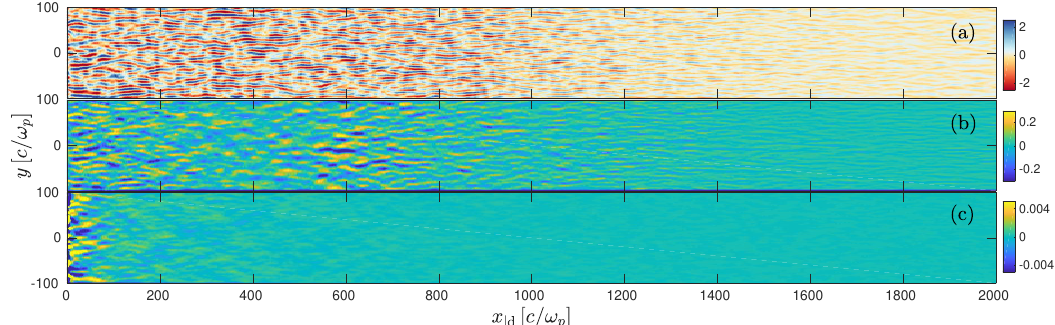
Figure 3. ( a ): Out-of-plane magnetic field, B z , as observed in a 2D3V pair shock simulation with Lorentz factor γ sh = 173 (i.e., γ u | d = 100) and σ = 0, illustrating the filamentary turbulence generated through the precursor region. The coordinates x | d and y are expressed in units of c / ω p , and x | d = 0 indicates the location of the shock front. ( b ): Density perturbations of the background plasma, n p ( x , y ) − (average taken over the transverse dimension), as a result of its interaction with the turbulence. ( c ): Same for the suprathermal particles, on a scale enlarged by 50 to enhance their weak modulations. From